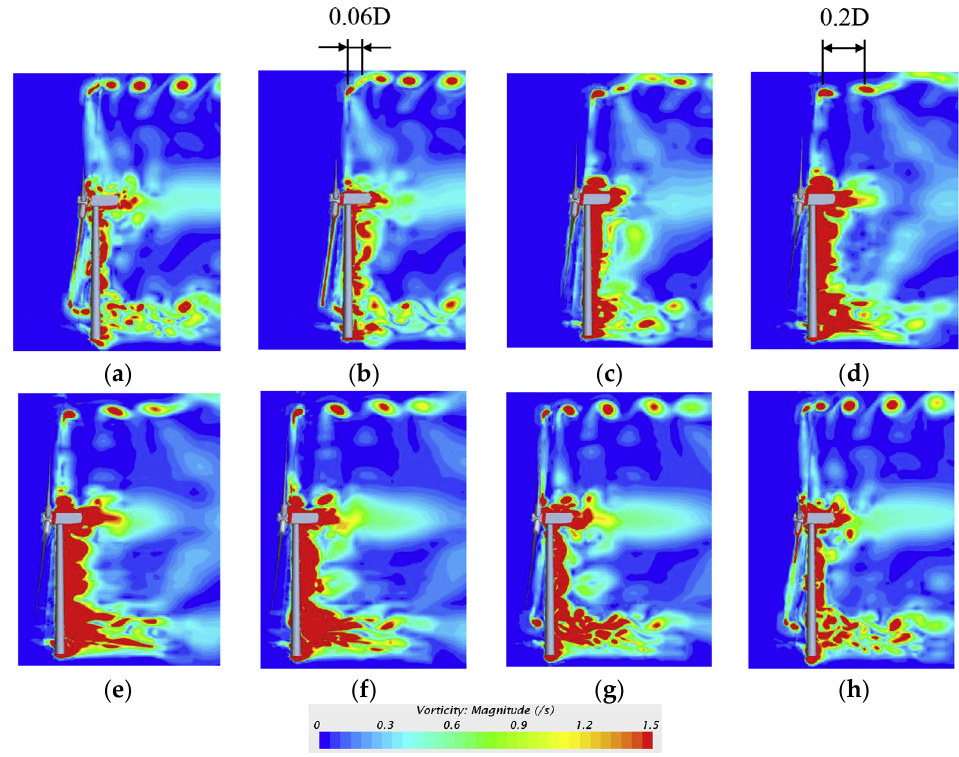
Figure 12. Visualization of instantaneous vorticity contours of the FOWT with the prescribed surge motion: ( a ) t = 0 T surge ; ( b ) t = 1/8 T surge ; ( c ) t = 2/8 T surge ; ( d ) t = 3/8 T surge ; ( e ) t = 4/8 T surge ; ( f ) t = 5/8 T surge ; ( g ) t = 6/8 T surge ; ( h ) t = 7/8 T surge [125]. Reproduced with permission from Tran and Kim, Renewable Energy; published by Elsevier, 2016.